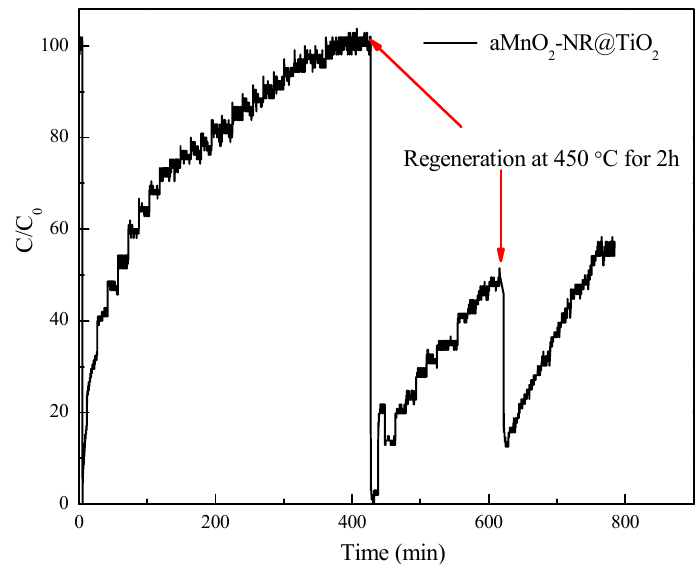
Figure 6. Hg 0 breakthrough curves of αMnO 2 -NR@TiO 2 under pure N 2 atmosphere. Reaction condition: 150 °C, GHSV = 180,000 h −1 .